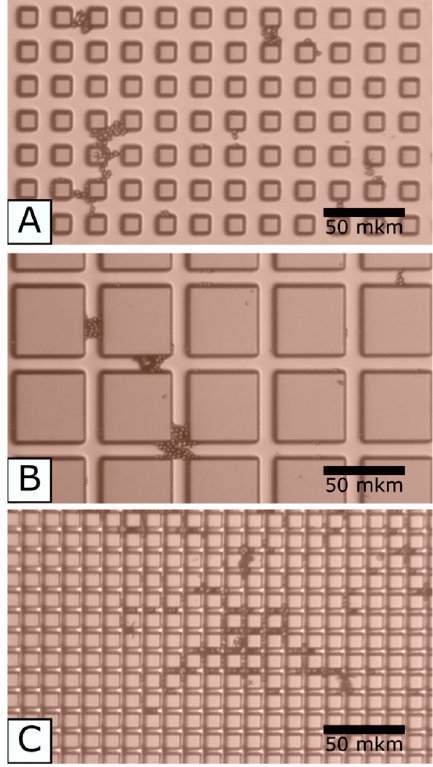
Figure 9. Optical microscopy images of the cells attached to the different substrates.